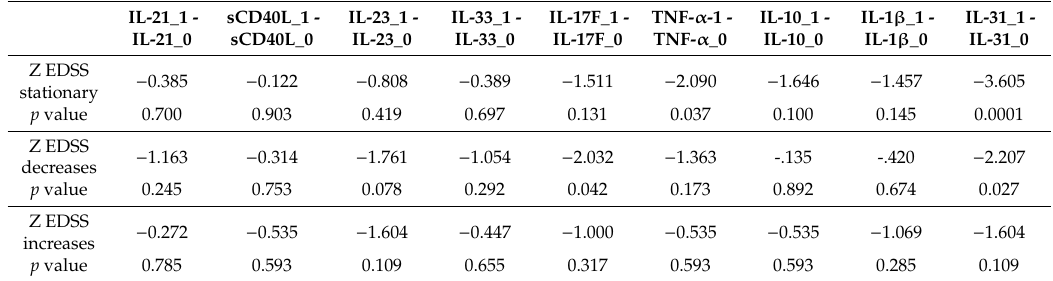
Table 3. Comparison between the initial and final cytokine values according to the Expanded Disability Status Scale (EDSS) score (Wilcoxon’s test).